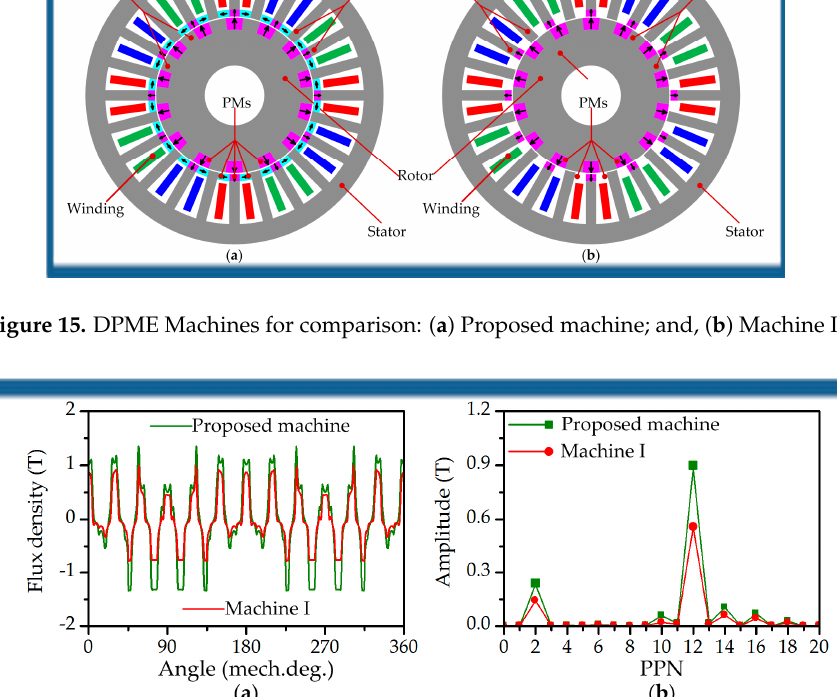
Figure 16. Comparison of magnetic fields excited only by stator PMs: ( a ) Flux density in the air-gap; ( b ) Corresponding harmonic spectrum.